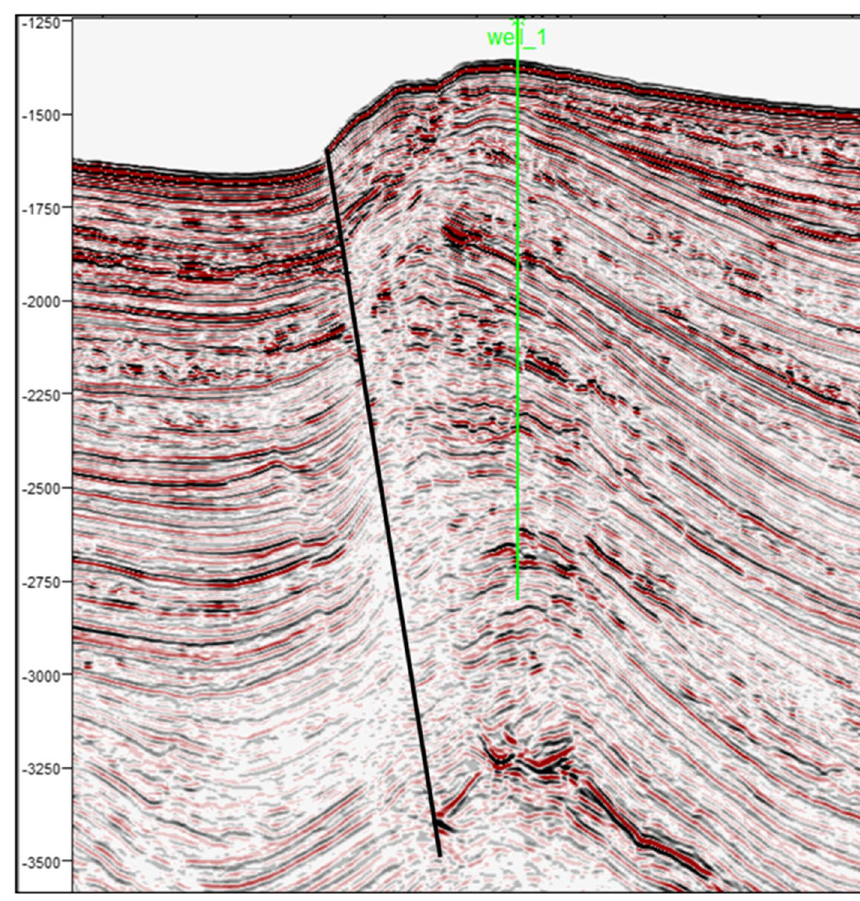
Fig. 13 N–S seismic line pass- ing through Well_1; the location of the drilled well is located in the upthrown side of reverse fault and intersected by growth normal